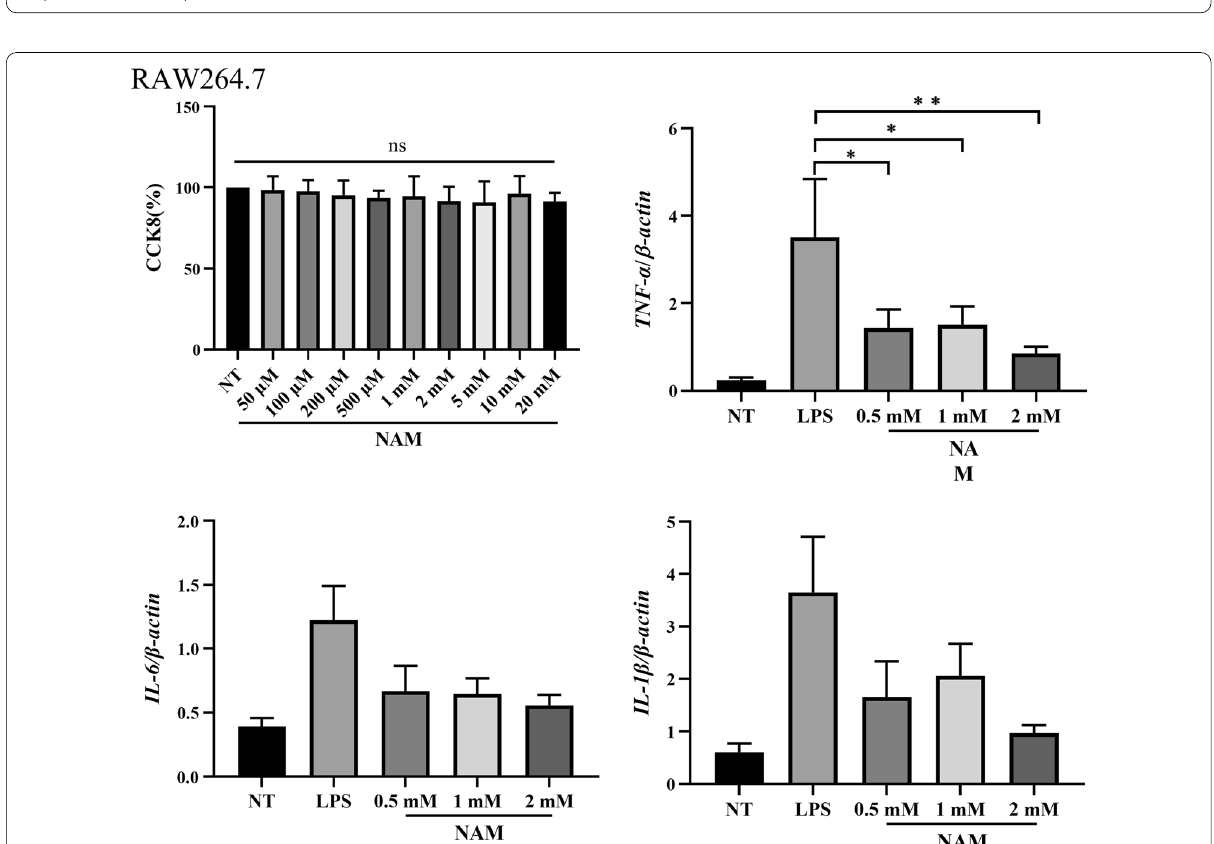
SD (* p < 0.05, ** p < 0.001, ±